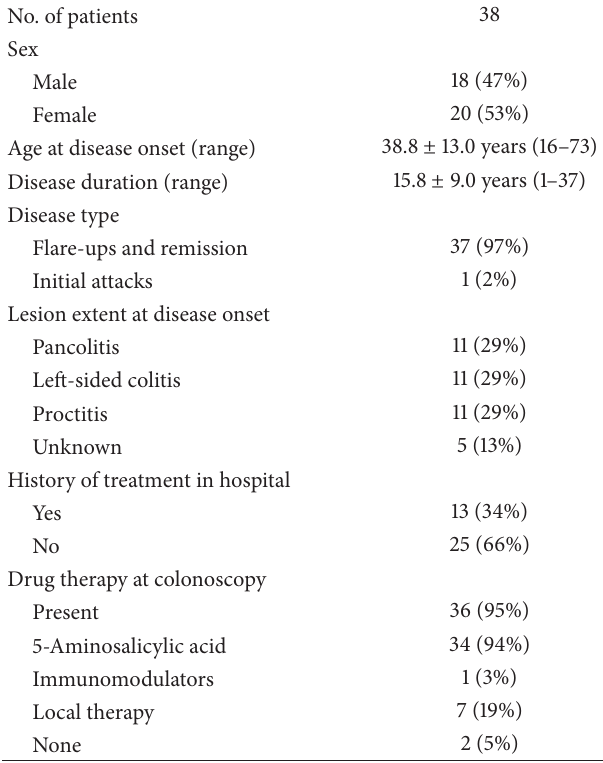
Table 1: Demographic characteristics of